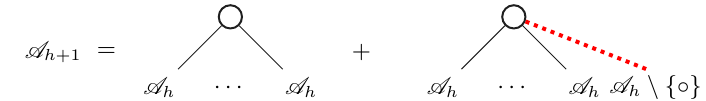
Figure 2. Symbolic equation for marked ordered trees of bounded height for height h ≥ 2